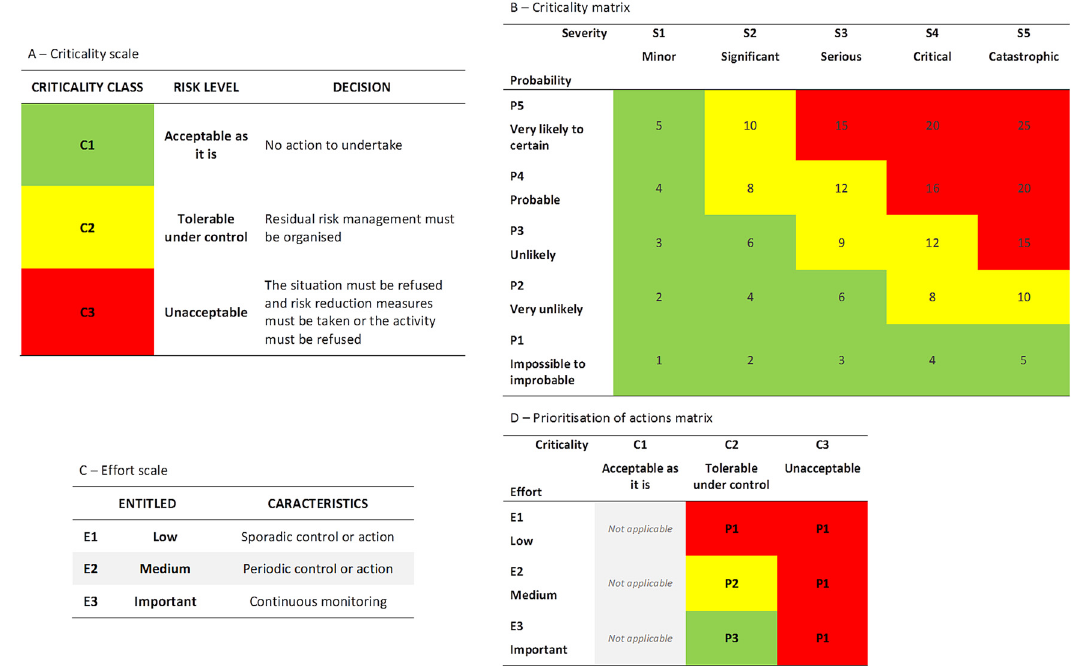
Figure 2: Decision